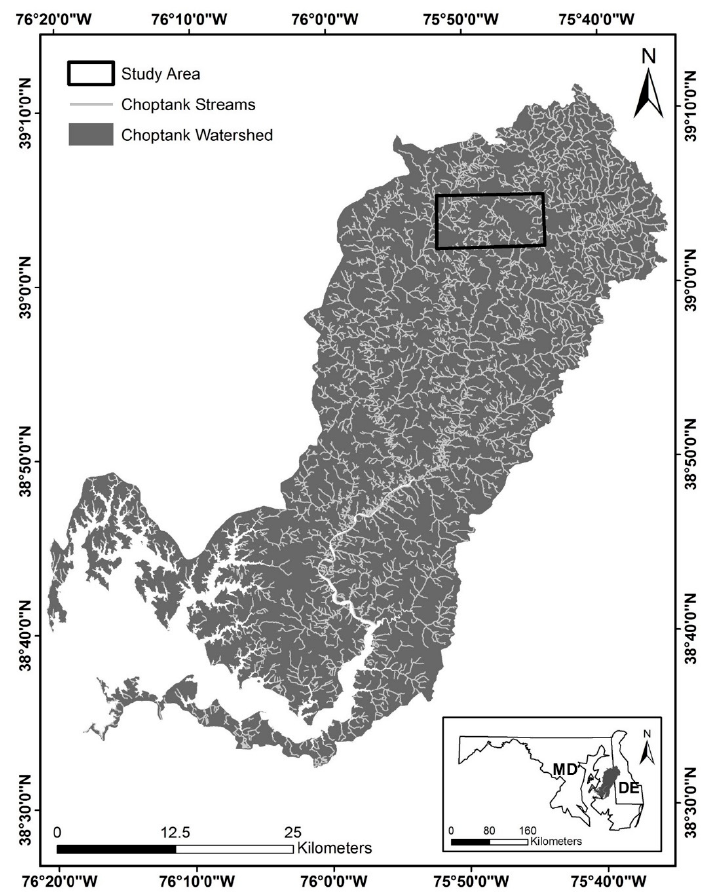
Figure 1. The location of the study area relative to the Choptank River Watershed and the states of Maryland (MD) and Delaware (DE). The Choptank River and its tributaries (gray lines) flow into the Chesapeake Bay. Stream and watershed data were obtained from the US Geological Survey National Hydrography Dataset (http://nhd.usgs.gov/data.html).